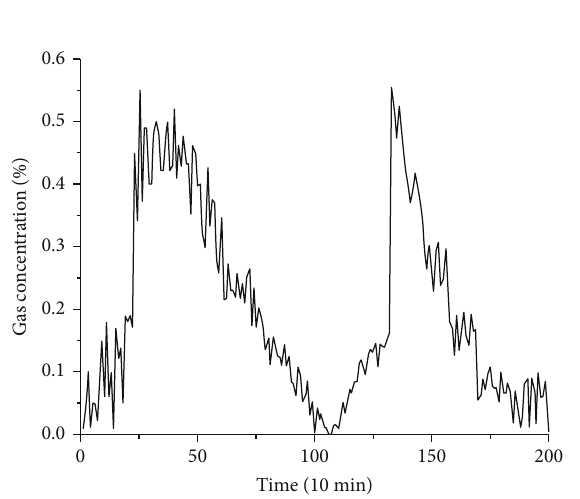
Figure 8: BOLL of gas concentration.